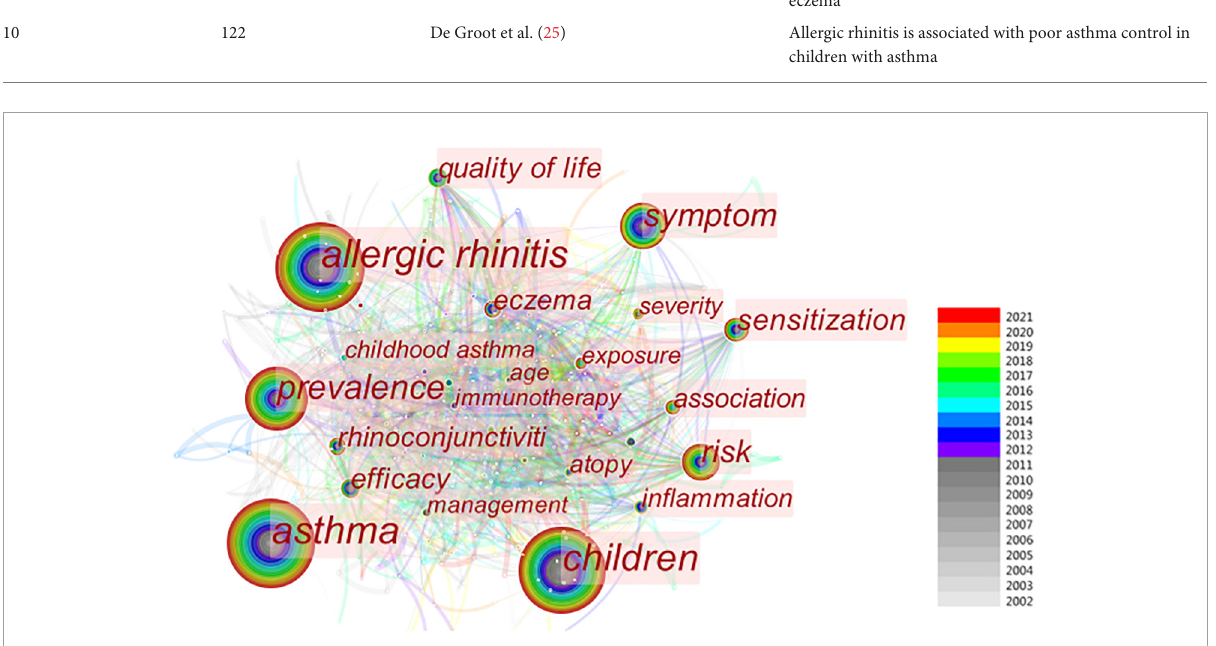
FIGURE7 Keywords of AR research in children.